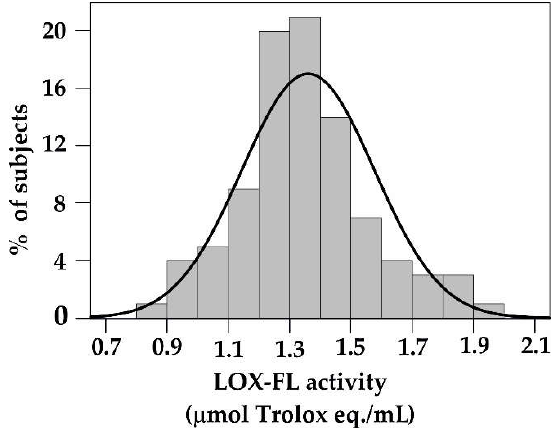
Figure 3. Distribution of serum Antioxidant Capacity values obtained by LOX–FL assay. Serum AC values were obtained from 92 subjects after an overnight fast.